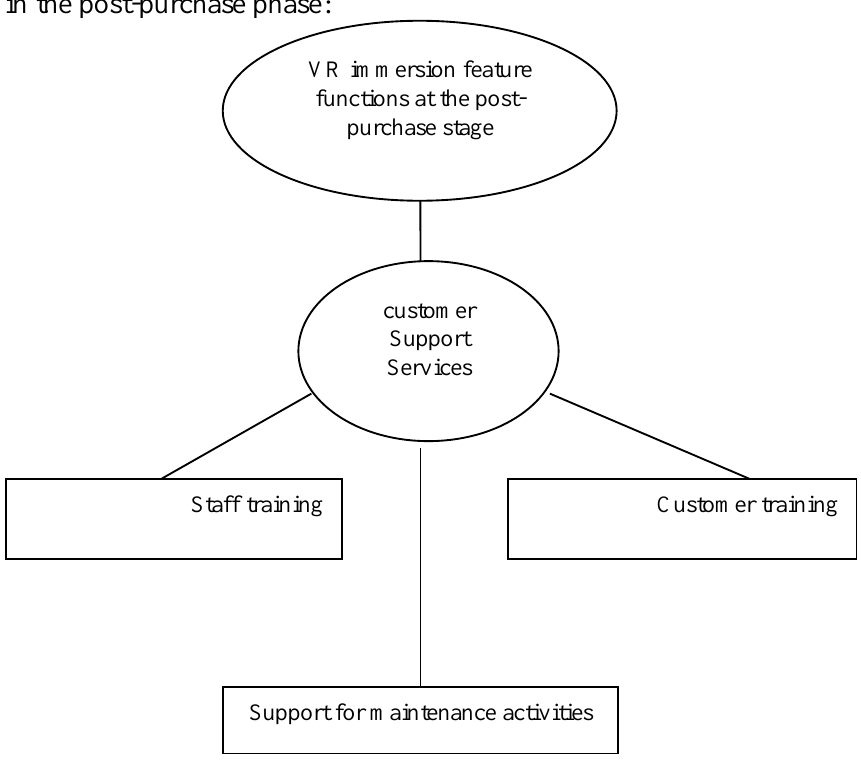
Figure 7. VR immersion feature functions in the post-purchase